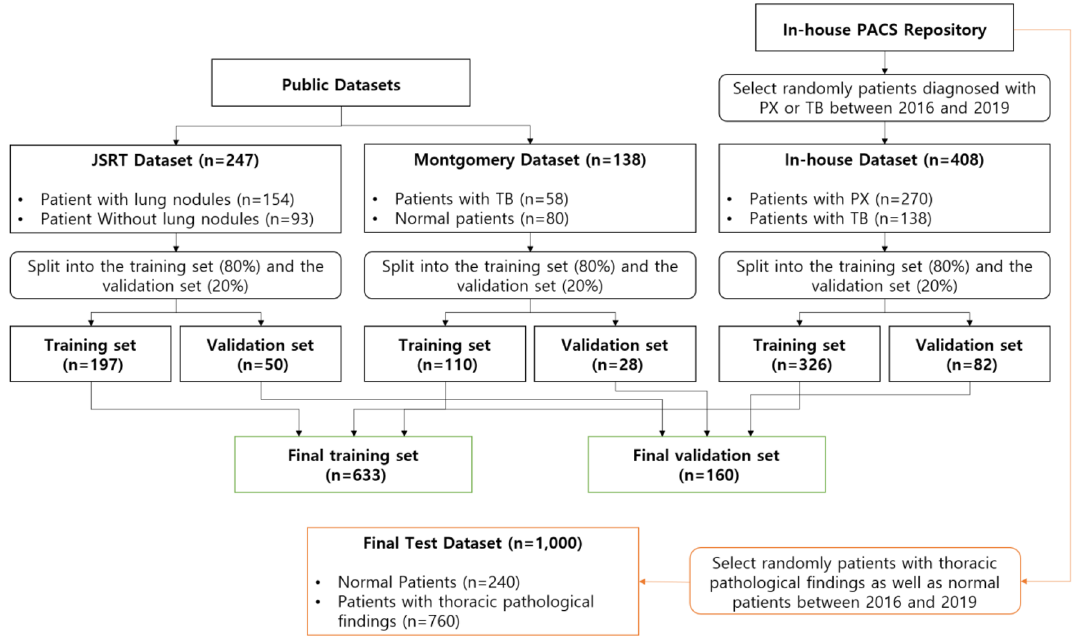
Figure 4. Flow chart for datasets. The final training and validation sets were used to train the DL models for lung and heart segmentation. The final test dataset was used to evaluate the segmentation-based methods using DL models. PACS picture archiving and communications system, PX pneumothorax, JSRT Japanese Society of Radiological Technology, TB tuberculosis, DL deep